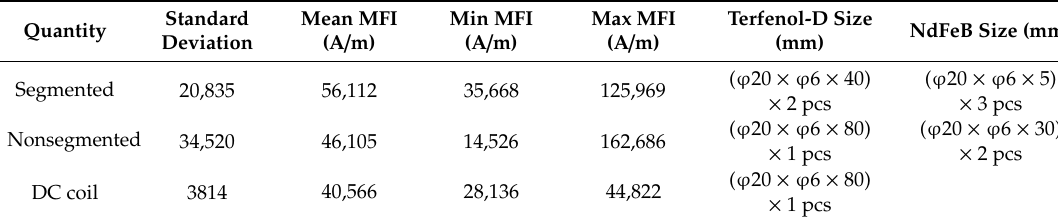
Table 3. Statistical quantities for the three configurations.